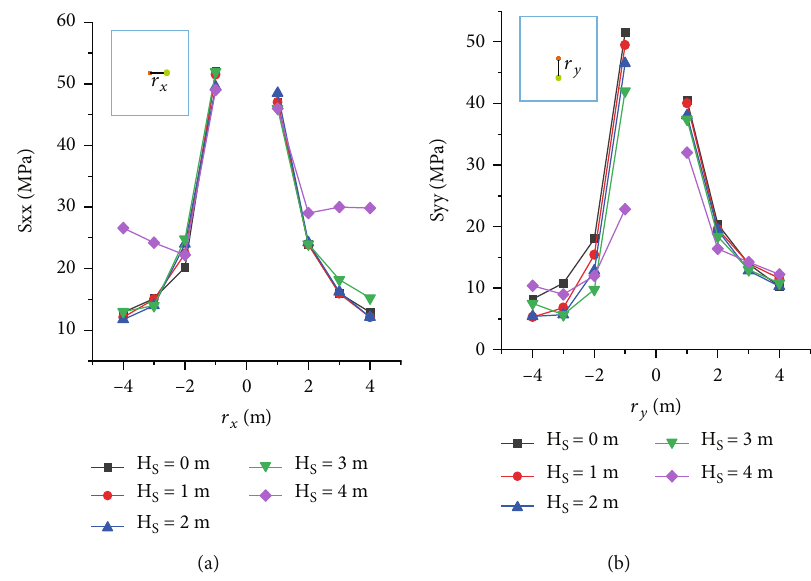
Figure 13: Variation curve of peak stress with r